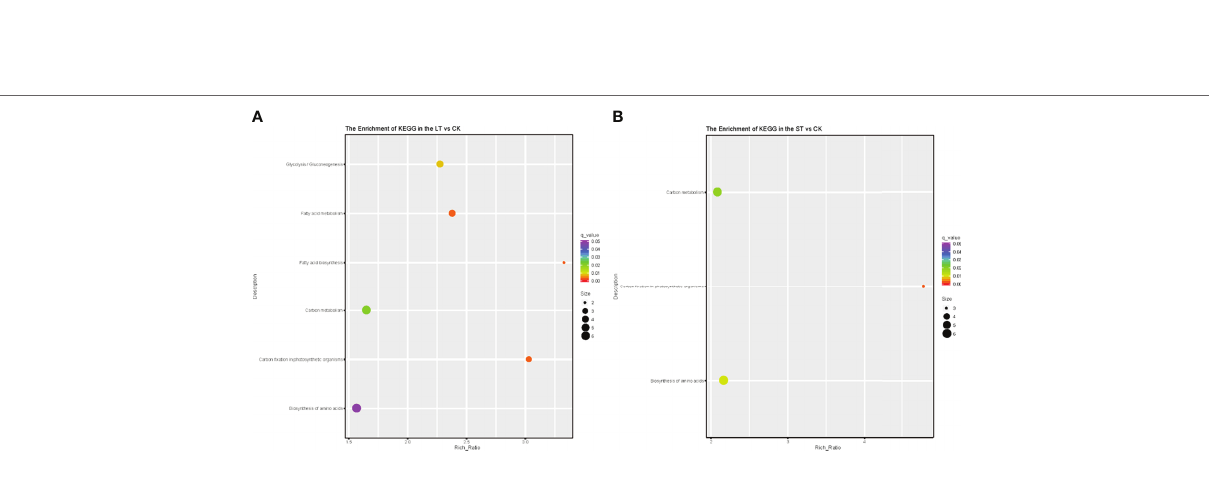
FIGURE 5 | Kyoto Encyclopedia of Genes and Genomes pathway enrichment of differentially expressed genes (DEGs) in the LT vs. CK (A) and ST vs. CK (B) . Number of DEGs was represented by the size of the circle. CK, control; ST, short-term acidification; LT, long-term acidification.